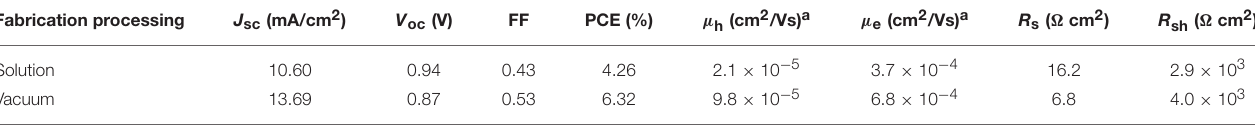
TABLE 1 | Comparison of device performance of solution-processed DIBSQ:PC 71 BM and vacuum-processed DIBSQ:C 70 SMBHJ cells. Fabrication